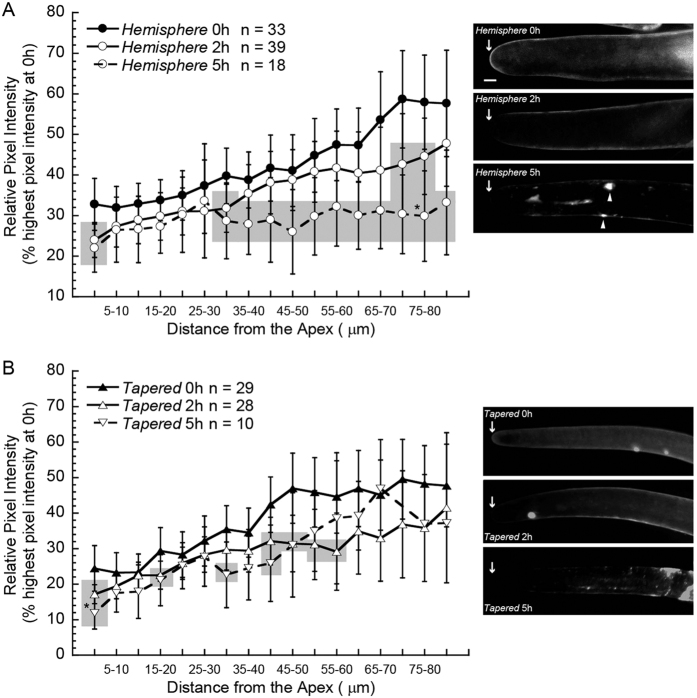
Pulse-labeling with a glucan-binding fluorophore demonstrated apical and distal zones of cell wall synthesis in cotton fiber tips.Living 5 DPA Gh fibers attached to ovules were exposed to 0.1% Tinopal LPW and imaged immediately (0 h) or rinsed and grown in vitro in the absence of the fluorophore for 2 or 5 h before imaging. Images show maximum Z-projections of representative tips. Grey boxes represent regions at 2 or 5 h that are significantly different from the corresponding region at 0 h (P < 0.05, T-test). Hemisphere
tips (A): At 0 h, wall fluorescence was lowest near the apex then increased to reach a plateau 70 μm back. After 2 h, apical fluorescence was 0.7-fold of the 0 h value, and significant reductions also occurred in the 30–35 μm and 70–80 μm distal regions. After 5 h, reduced apical fluorescence as compared to 0 h was again observed, but there was no difference compared to 2 h. Fluorescence was decreased 0.5- to 0.7-fold between 30–85 μm as compared to 0 h. Tapered
tips (B): At 0 h, wall fluorescence was lowest near the apex then increased to reach a plateau 45 μm back. After 2 h, apical fluorescence was 0.7-fold of the 0 h value and significant reductions also occurred in the 15–20 μm and 40–60 μm distal regions. After 5 h, the apical fluorescence was reduced further to 0.5-fold of the 0 h value. Overall, the distal regions of tapered tips showed less change than hemisphere tips during 2–5 h growth after the Tinopal pulse. Scale bar = 5 μm applies to all images. Arrows show the location of the fiber apex. Measurement regions with bright spots of CFML (arrowheads) were excluded from quantitative analyses. All images were acquired under the same conditions and intensity data were normalized to the highest pixel intensity at 0 h within the population of either hemisphere (A) or tapered tips (B). Values were graphed at the midpoint of the region measured. Error bars represent 95% confidence intervals.